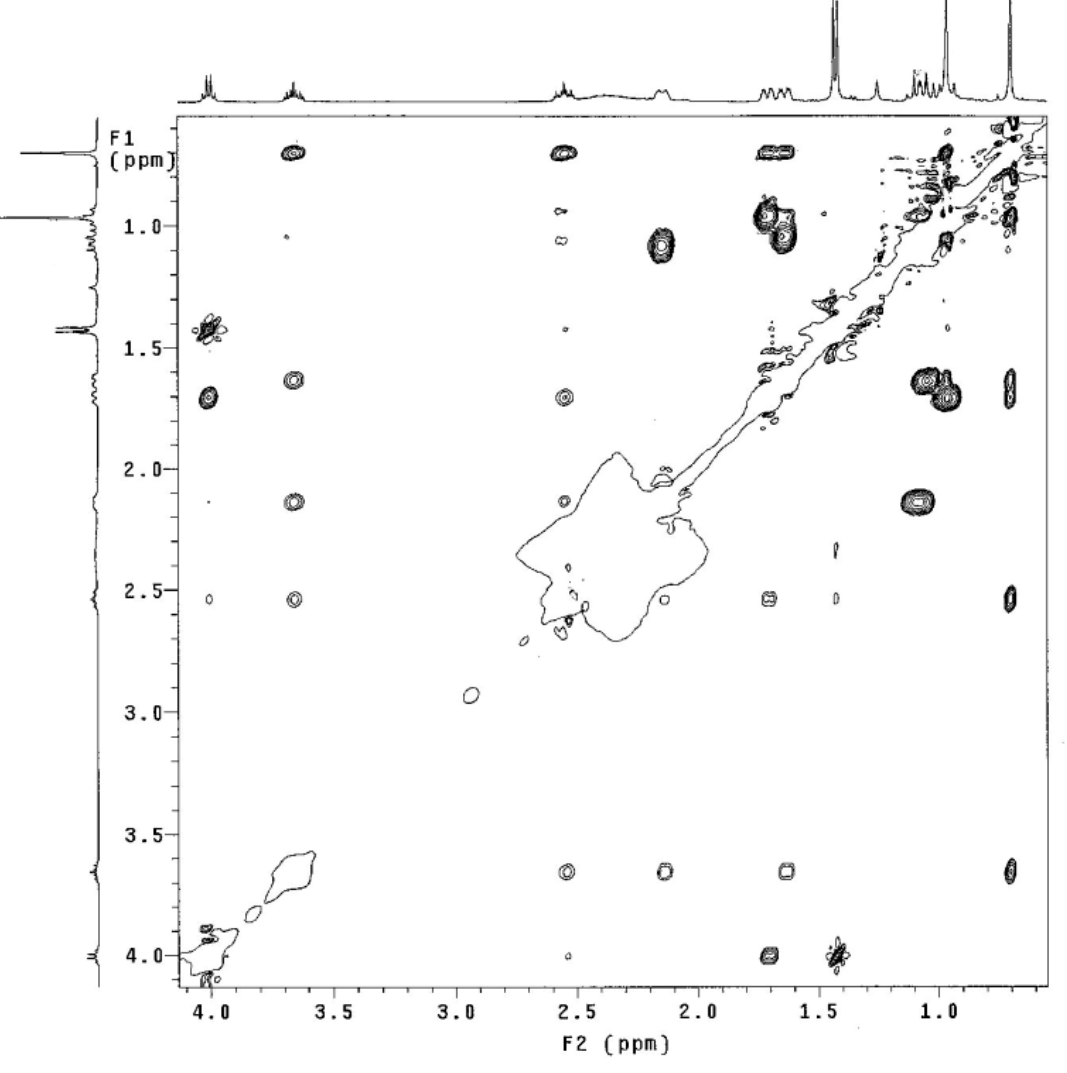
for compounds cis - 4 and trans - 4 . 2 ec